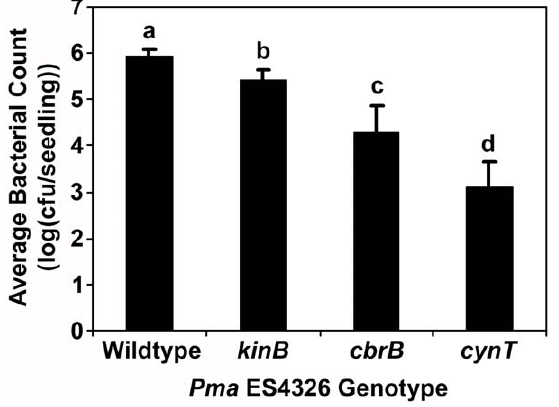
Figure 4. Growth in liquid-grown Arabidopsis seedlings of Pma ES4326 transposon disruptants whose growth in soil-grown plants is not impaired. Wells were inoculated with disruptants of the sensory box histidine kinase genes cbrA or kinB , or the carbonic anhydrase gene cynT . Bacterial populations were quantified at three days post-inoculation by dilution plating. Error bars reflect standard deviation of the mean of eight replicate samples. Letters above data points indicate statistical significance groups as determined by pairwise Student’s t-tests ( a =0.05). Three independent experiments were performed with similar